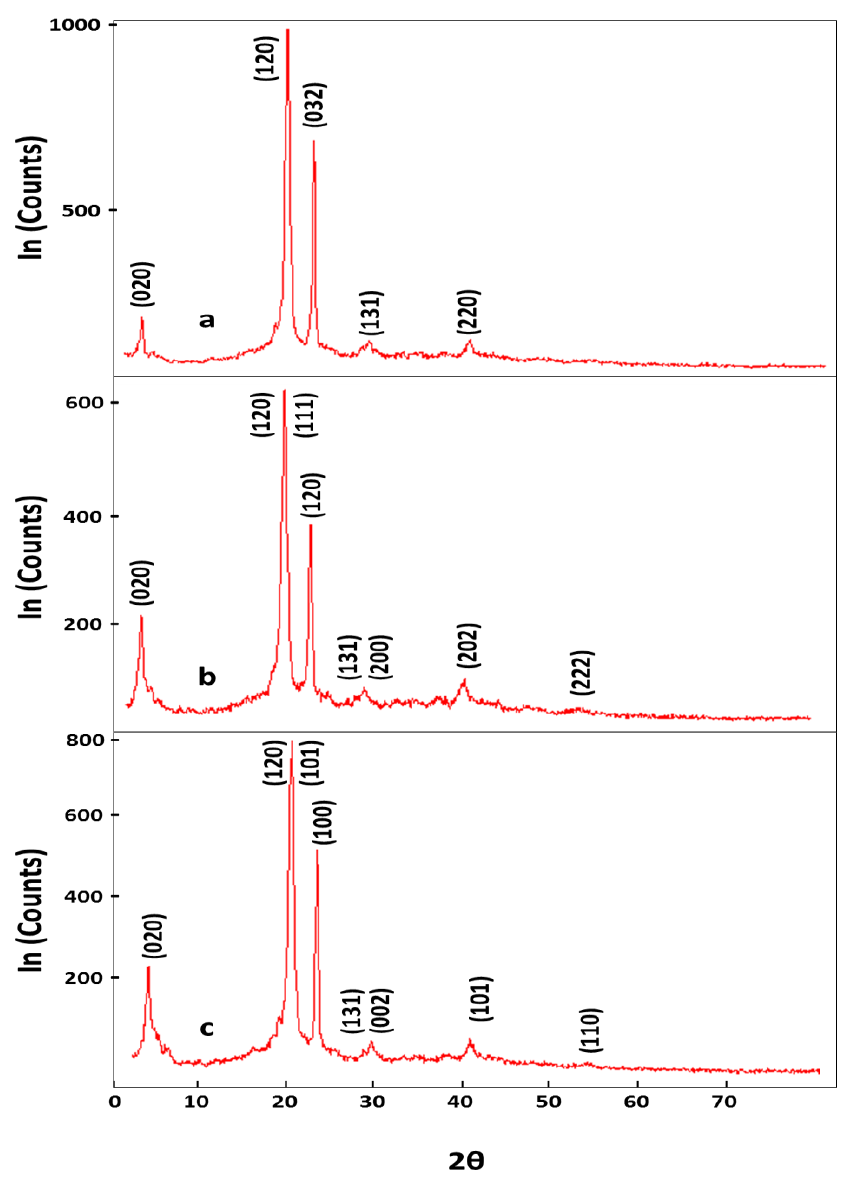
Figure 3. XRD charts of ( a ) PES, ( b ) PES-WO 3 NC, and ( c ) PES-ZnO NC composites.